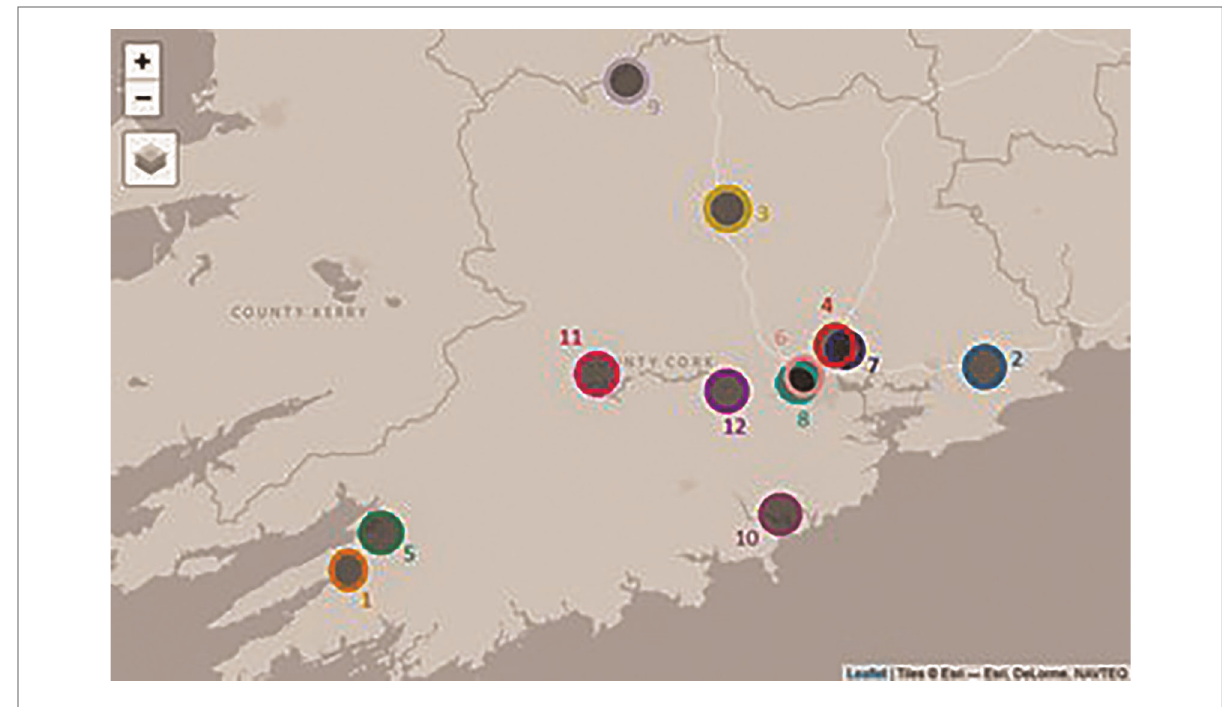
FIGURE 2 Map of suicide clusters occurring in County Cork during the period 2008 – 2017.